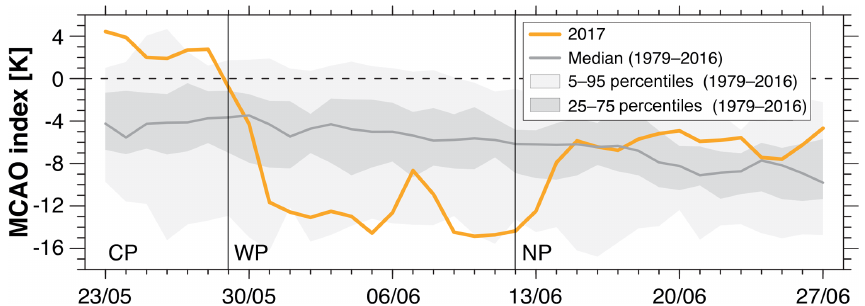
Figure 6. Marine cold air outbreak (MCAO) index for the eastern Greenland Sea (75.00–80.25 ◦ N, 4.50–10.50 ◦ E) over the ACLOUD/PASCAL measurement period (23 May–26 June 2017), based on ERA-I data. The gray median line and percentile shading refer to the climatology over 1979–2016, while the black vertical lines separate the three key periods (CP, WP, and NP) in 2017 defined in Sect.